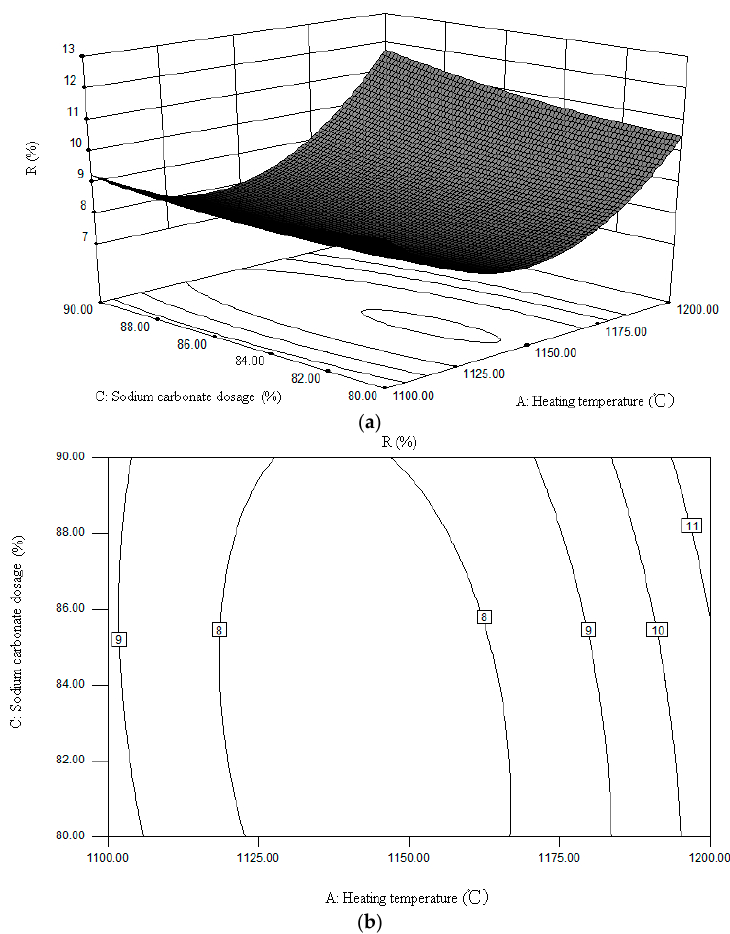
Figure 5. ( a ) Response surfaces of heating temperature–sodium carbonate dosage and ( b ) contour of heating temperature–sodium carbonate dosage plot.